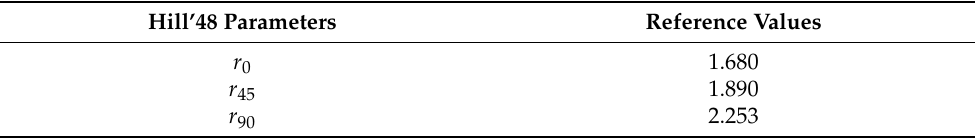
Table 1. Plastic anisotropy coefficients r α used for obtaining the reference cruciform biaxial test [63].